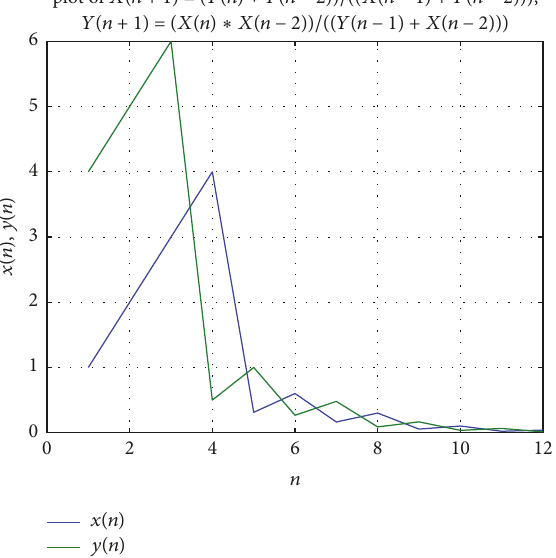
Figure 1: This figure shows the solution of